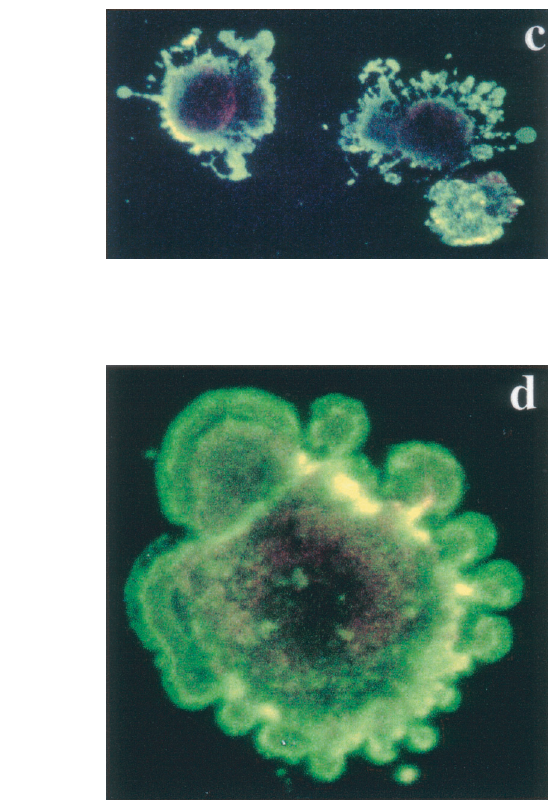
Figure 5: Immunofluorascence staining with annexin V-enhanced green fluorescent protein (EGFP) and propidium iodide (PI). (a), (b) Control BB-88 cells ( 24 hours) showing red staining due to PI throughout the cell ( × 400). (c), (d) Tamoxifen treated BB-88 cells ( 8 hours, 5 µ g/ml) showing annexin V-EGFP green staining in the plasma membrane ((c) × 400, (d) × 900) and blebs on cells undergoing